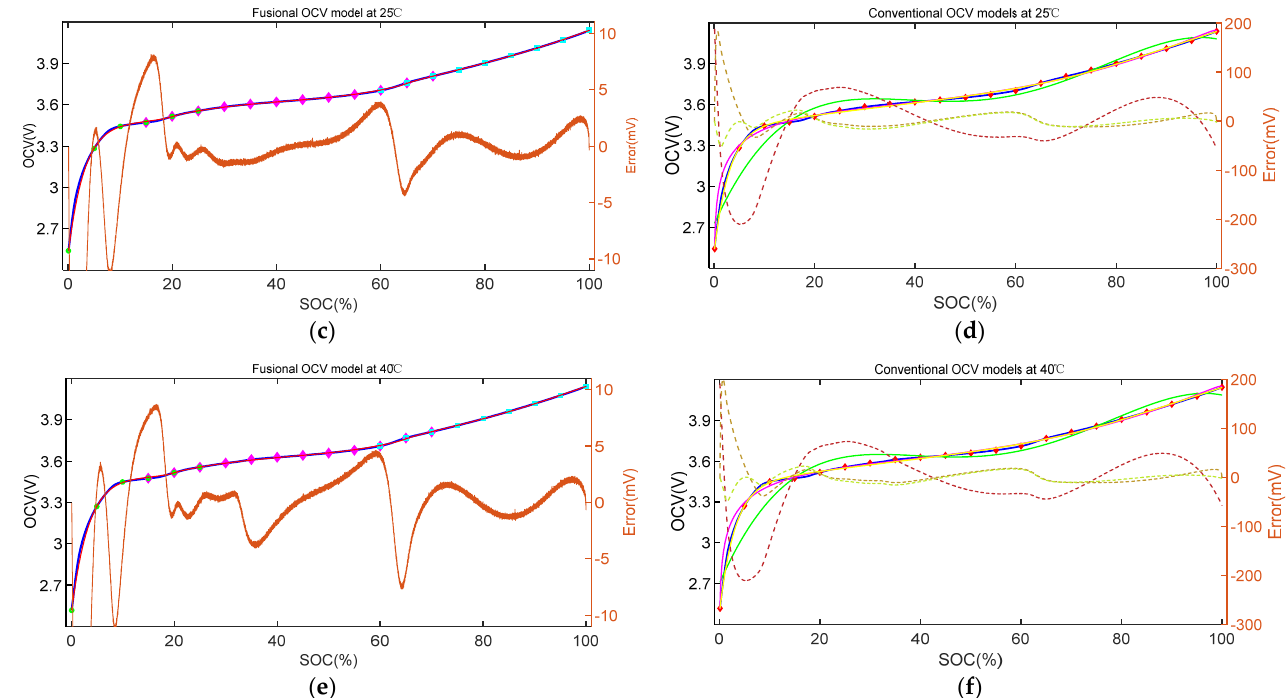
Figure 9. OCV models of NMC battery at 10 °C, 25 °C, and 40 °C. ( a ) Fusional OCV model at 10 °C. ( b ) Conventional OCV models at 10 °C. ( c ) Fusional OCV model at 25 °C. ( d ) Conventional OCV models at 25 °C. ( e ) Fusional OCV model at 40 °C. ( f ) Conventional OCV models at 40 °C.